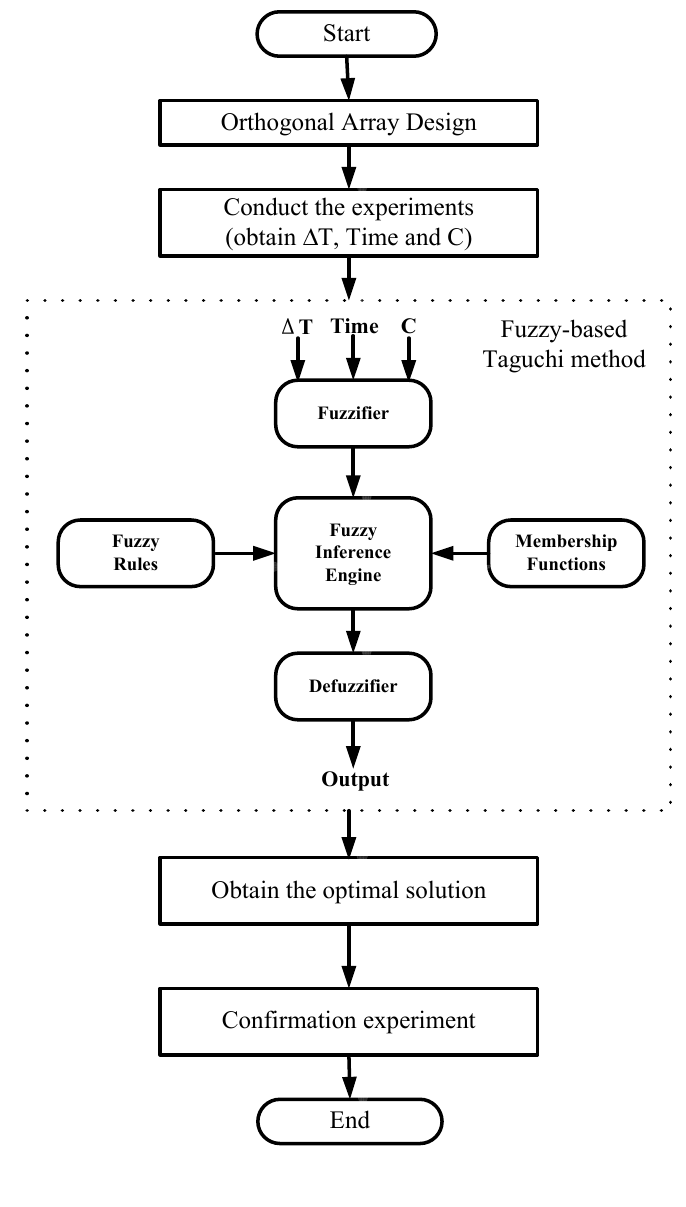
Figure 5. Implementation procedures of the utilized fuzzy-based Taguchi